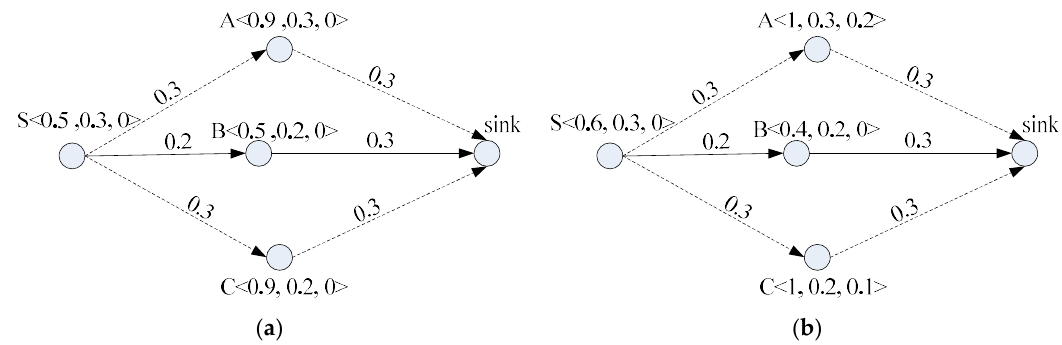
Figure 1. Traditional routing. ( a ) Before data delivery; ( b ) After data delivery using route S → B → Sink.